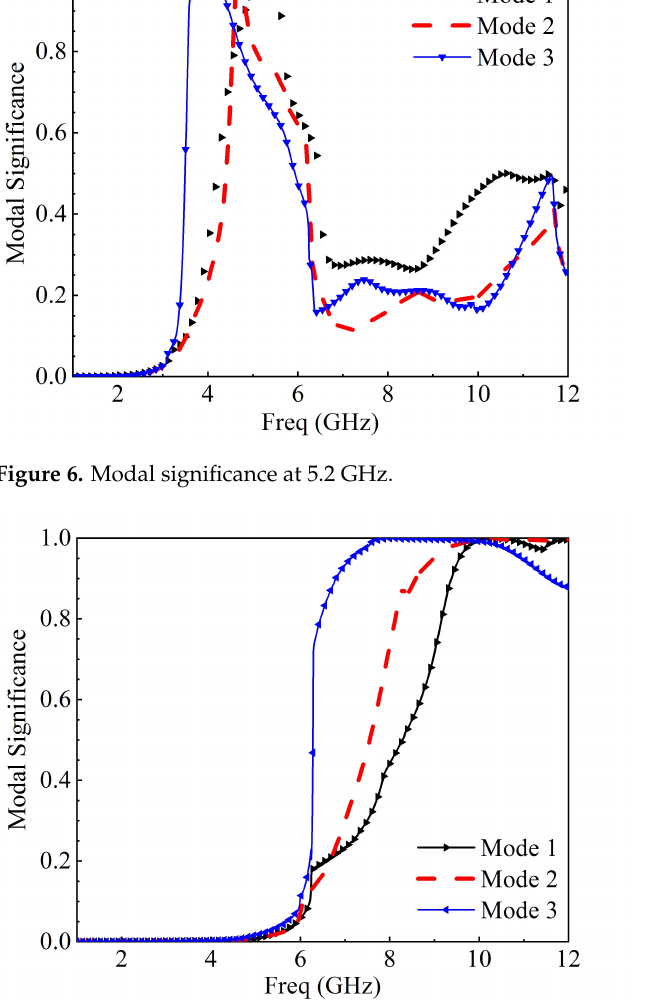
Figure 7. Modal significance at 10.6